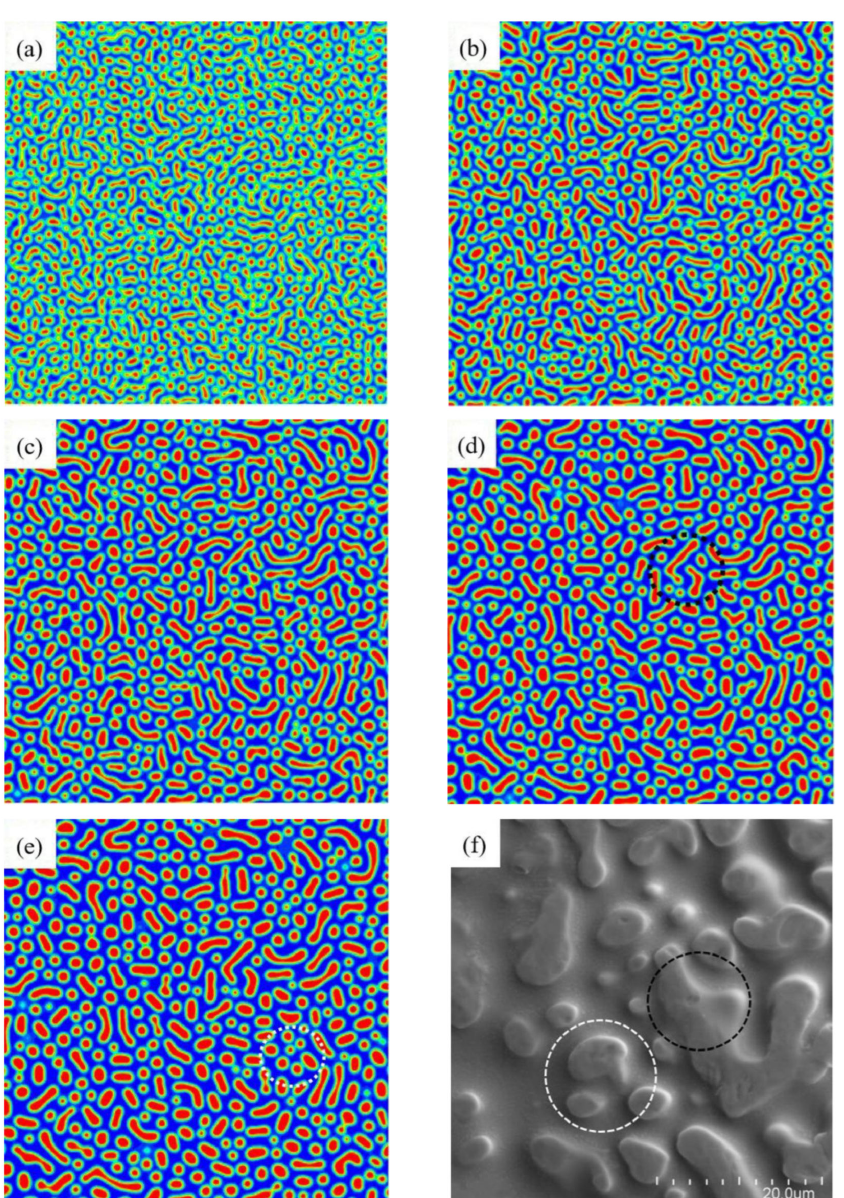
Figure 7. Time evolution of the microstructure due to spinodal decomposition by the phase field simulations: ( a ) t = 20; ( b ) t = 40; ( c ) t = 60; ( d ) t = 80; ( e ) t = 100; ( f ) a SEM image showing the pattern and morphology of Sn-rich phase patterns that consistent well with simulation